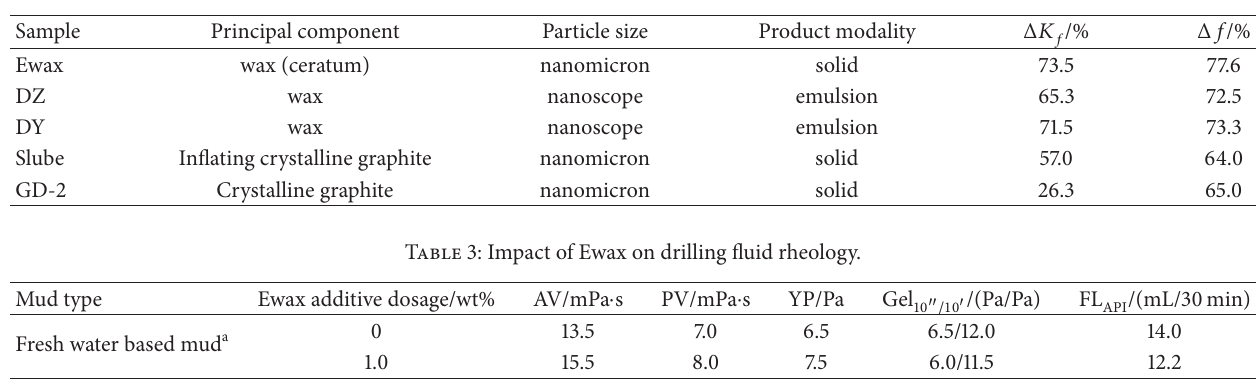
Table 2: Comparison of different lubricants.